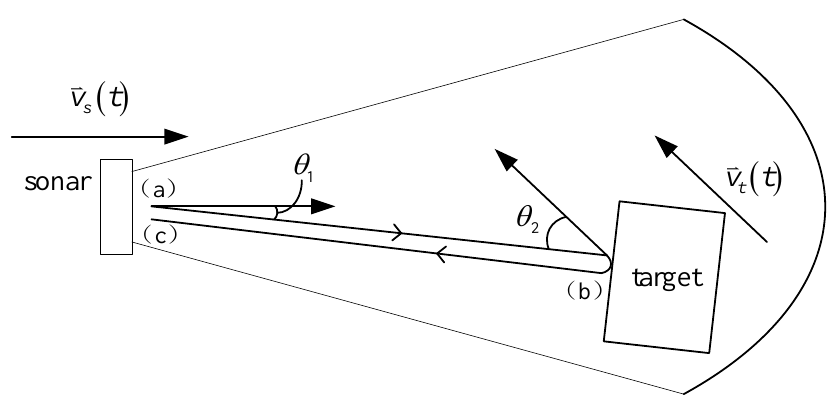
Figure 4. The propagation of the ultrasonic